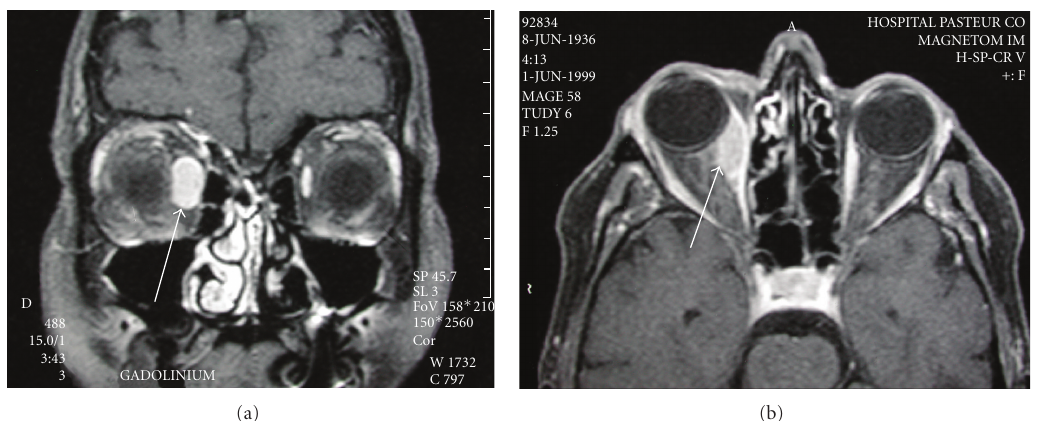
Figure 1: High signal intensity on MRI images in an orbital myositis related to Lyme